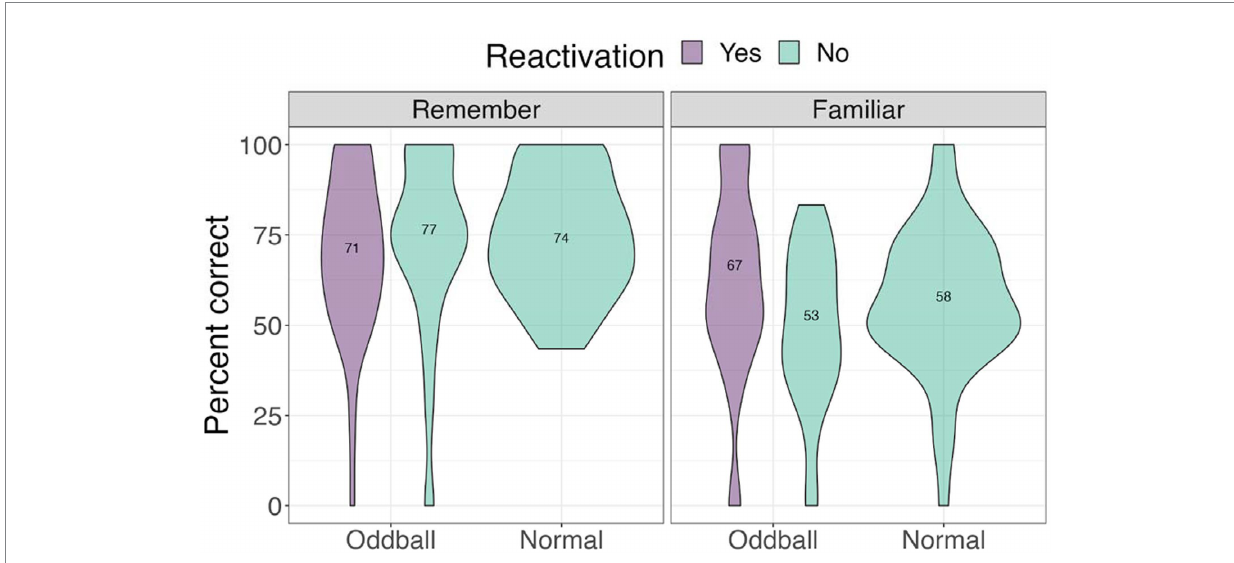
FIGURE 11 Mean accuracy for the visual recognition by different confidence levels task in Experiment